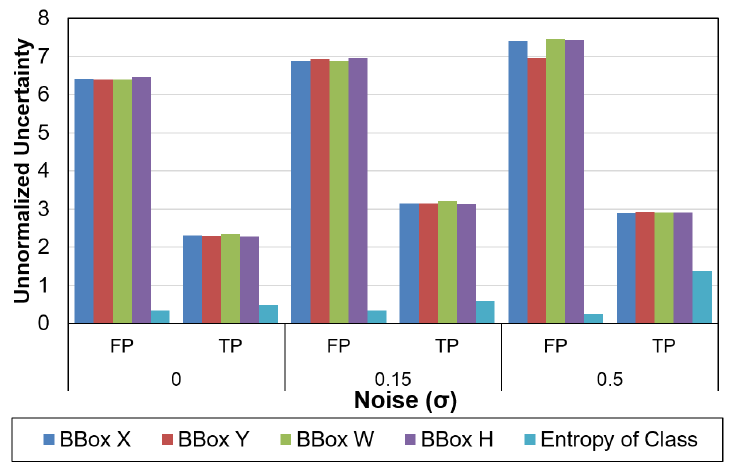
Figure 9. Uncertainty for True Positives (TP) and False Positives (FP) at different levels of sensor noise. Reprinted with permission from ref. [12]. Coprright 2020 IEEE.